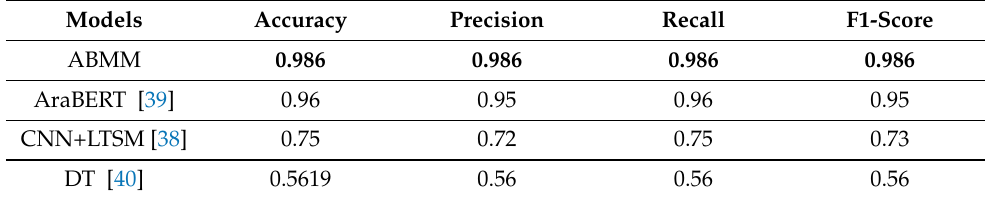
Table 8. The comparative study with state-of-the-art